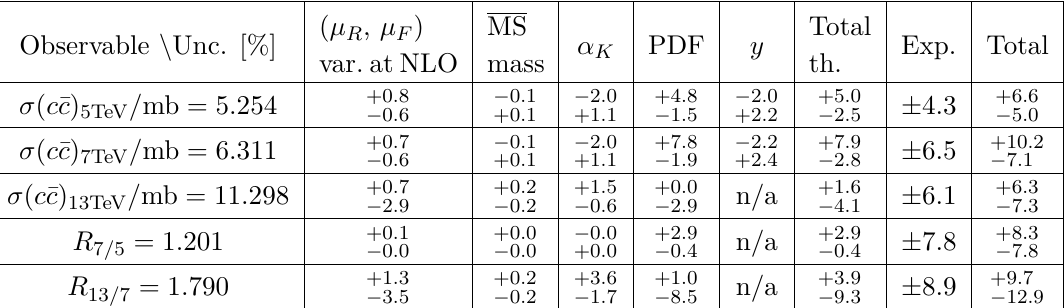
Table 5 . Extrapolated total charm production cross-sections and their ratios at different center- of-mass energies together with uncertainties from parametric variations of the scales at NLO, the mass m c ( m c ) ± 0 . 03 GeV, α K ± 1 . 7 , PDFs and the rapidity y ALICE , LHCb ± 0 . 5 . The correlation factor between R and R is − 0 . 61 . α S uncertainties are negligible compared to the PDF ones, 7 / 5 13 / 7 computed using as a baseline the CT14 PDF set of eigenvectors at